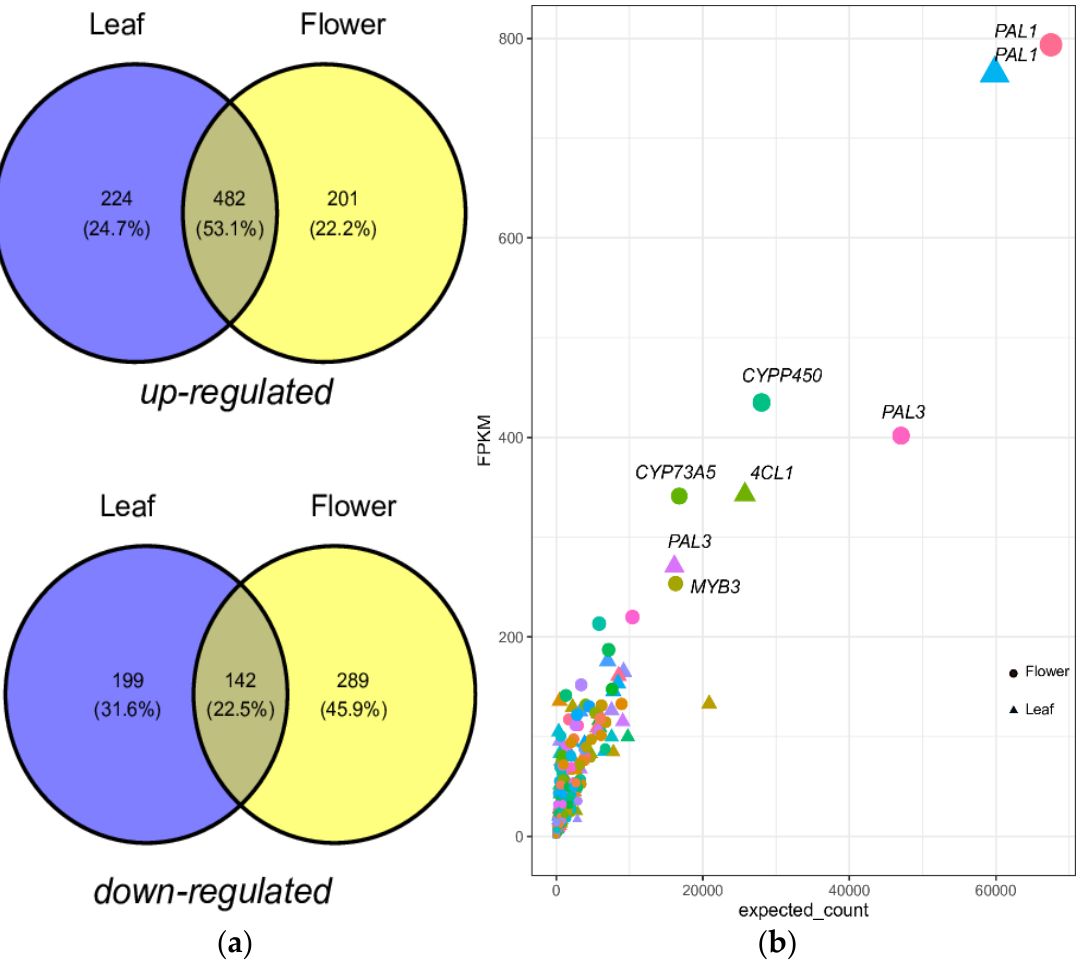
Figure 2. ( a ) A Venn diagram shows up and downregulation of PPP in A. spathulifolius leaf and flower. ( b ) The geom point plot shows the upregulated differential expressed genes of PPP in leaf and flower of A. spathulifolius.